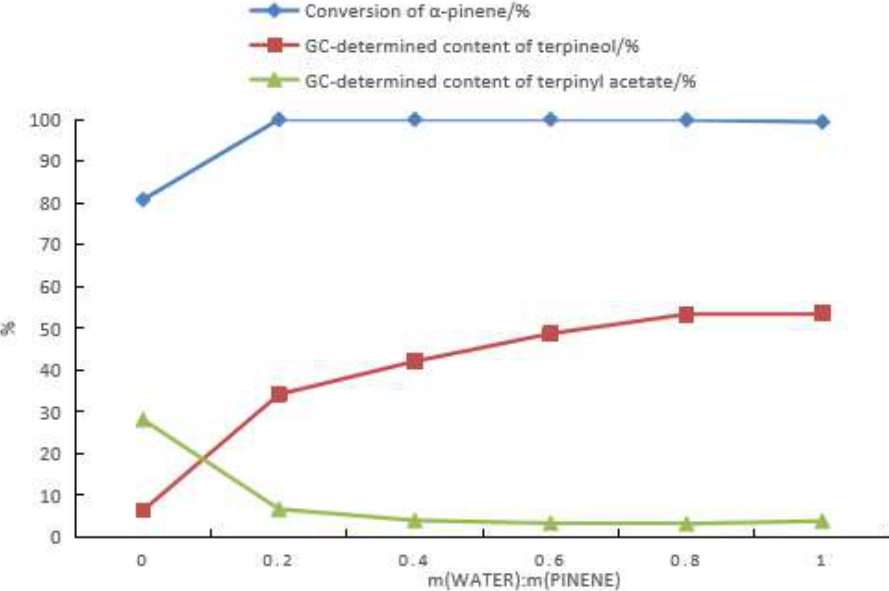
Figure 3. The effect of water on the hydration of α -pinene with the following reaction conditions: